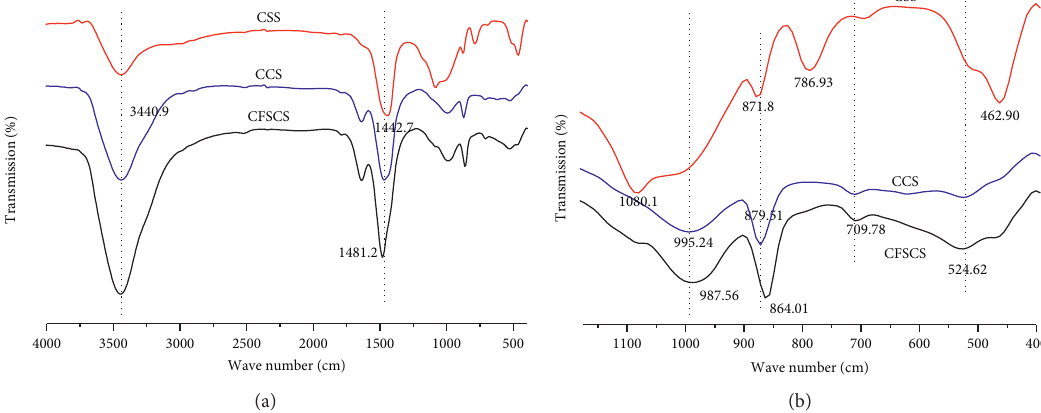
Figure 11: (a) FTIR spectra of mortar samples at 7 d. (b) A larger version of part of the curve in (a). CSS: standard mortar; CCS: coral mortar; CFSCS: coral mortar with 15% fly ash and 15% slag.